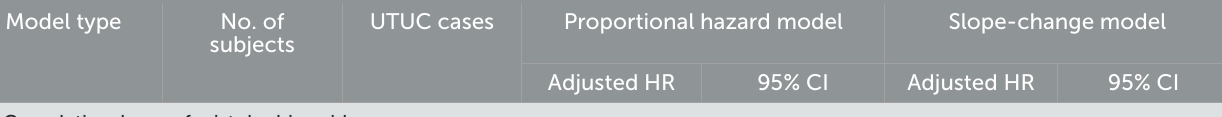
TABLE 2 Adjusted hazard ratios for the occurrence of upper tract urothelial carcinoma between 2005 and 2016, assuming proportional hazard and time varying effect of cumulative doses of aristolochic